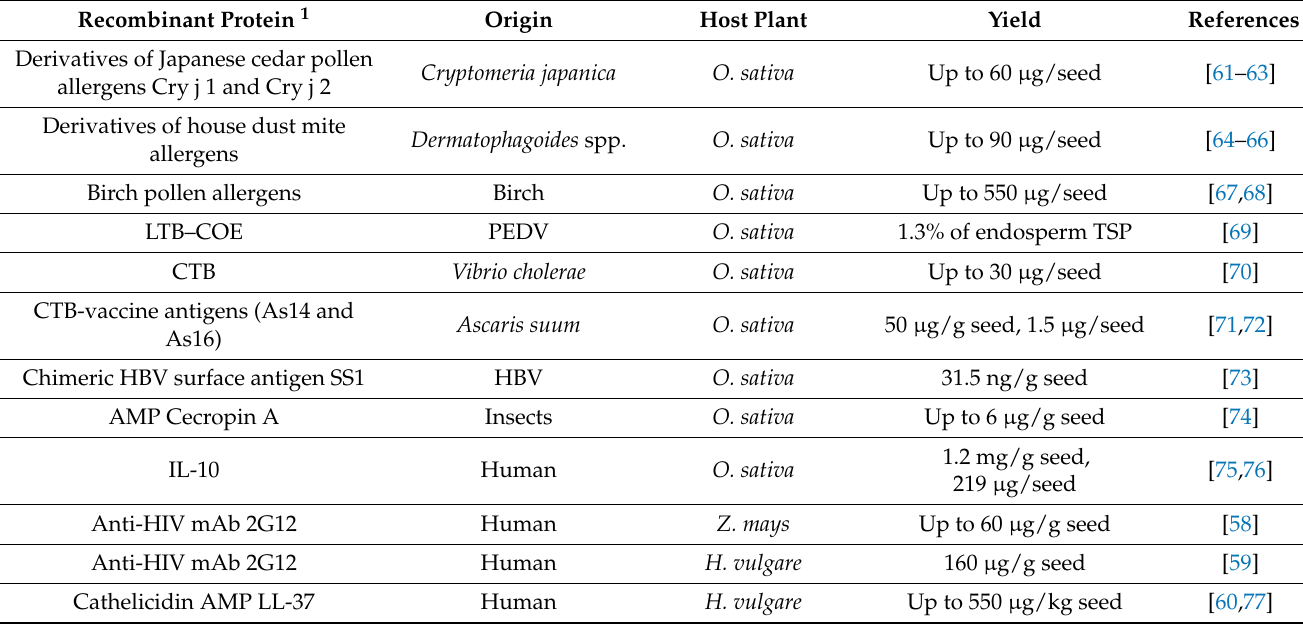
Table 1. Examples of the seed endosperm accumulation of recombinant pharmaceutical proteins in stable transgenic cereal